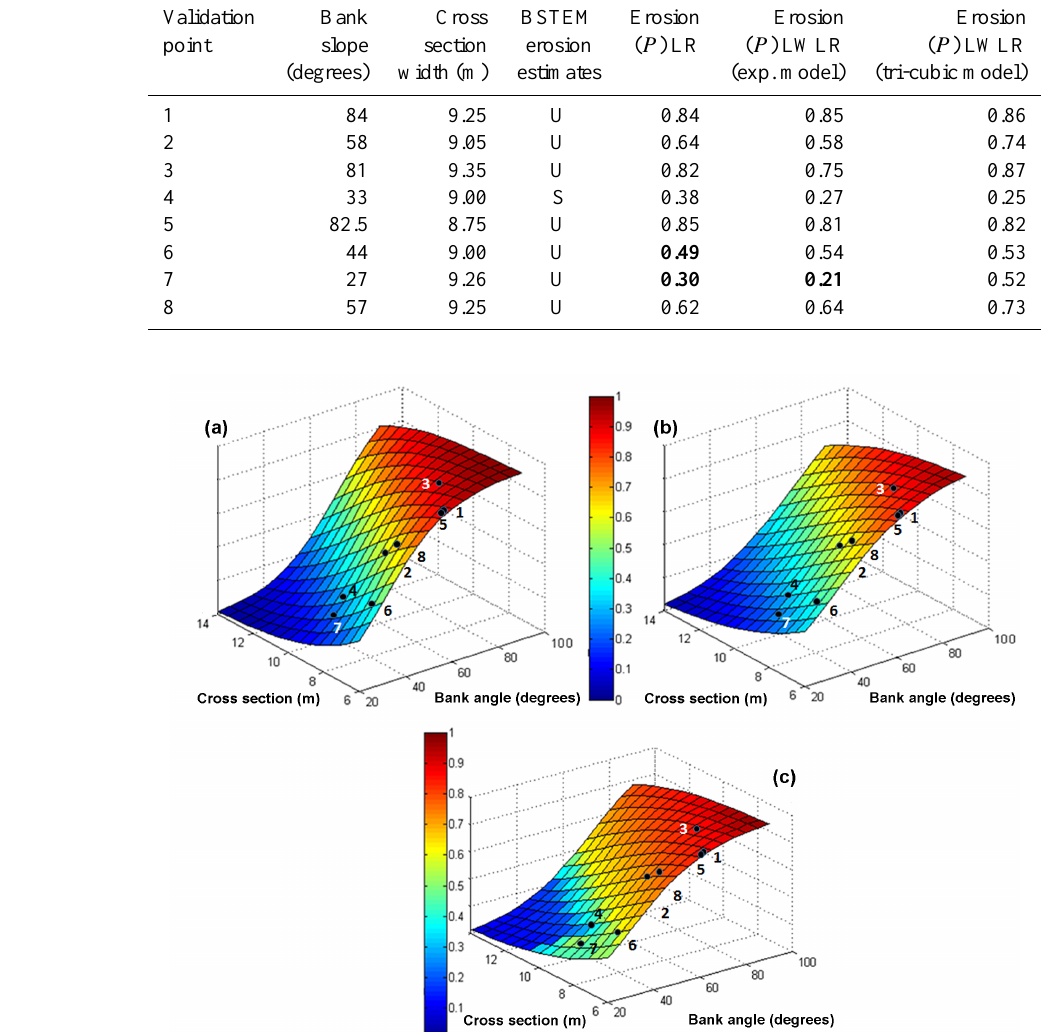
Figure 5. Erosion probability predictions using (a) LR, (b) LWLR with the exponential weighting function and (c) LWLR with the tri-cubic weighting function versus variable independent values at random ungauged Koiliaris riverbank locations. The black dots indicate the eight validation